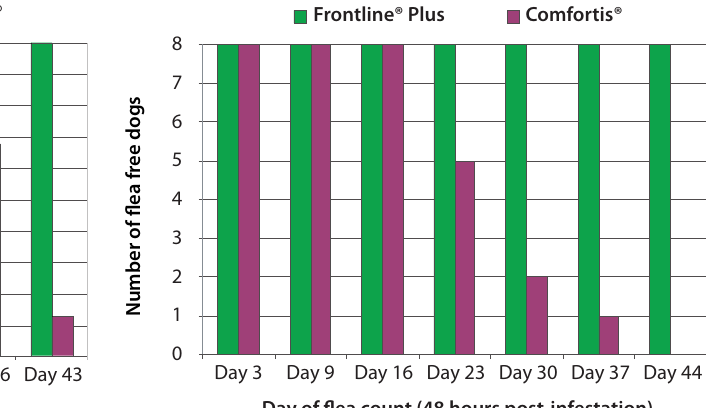
Table III. – Compared killing efficacies of the two treatments on adult fleas at 24 and 48 hours counts.